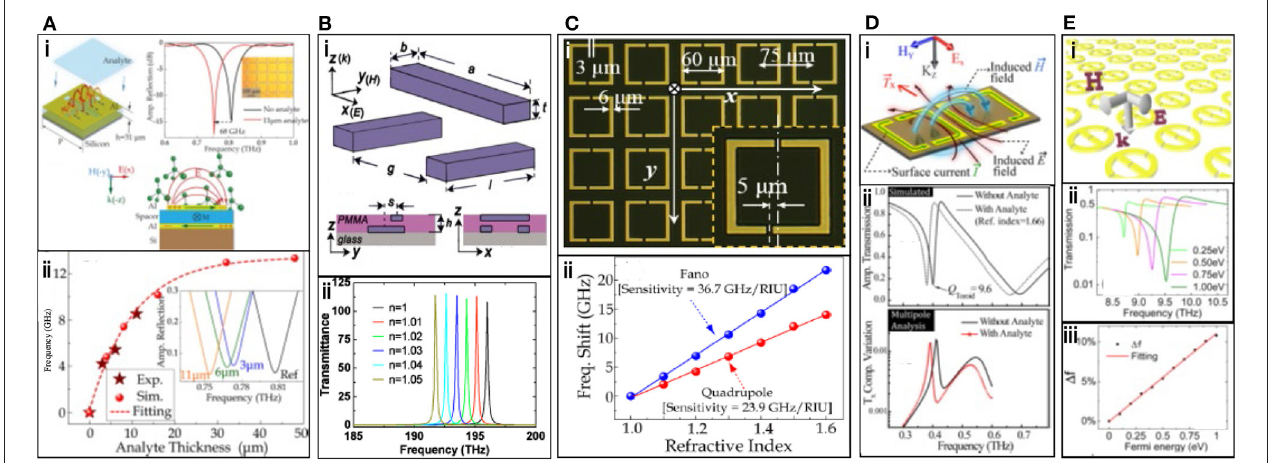
FIGURE 2 | Performance enhanced metamaterial unit based sensors. (A) CSA and CCSA based Fabry-Perot cavity type sensors and the sensing performance [25, 26], (B) schematic illustration of EIT-like metamaterial unit and the enhanced narrow transparency windows at different refraction indexes [54], (C) microscopic image of the terahertz asymmetric Fano resonances shift with the change in refractive indexes [ 24], (D) operating mechanism for the toroidal resonance and the corresponding resonance changing performance [55], and (E) schematic illustration for the newly developed graphene-inspired anapole resonator and the accordingly resonance changings under different Femi levels